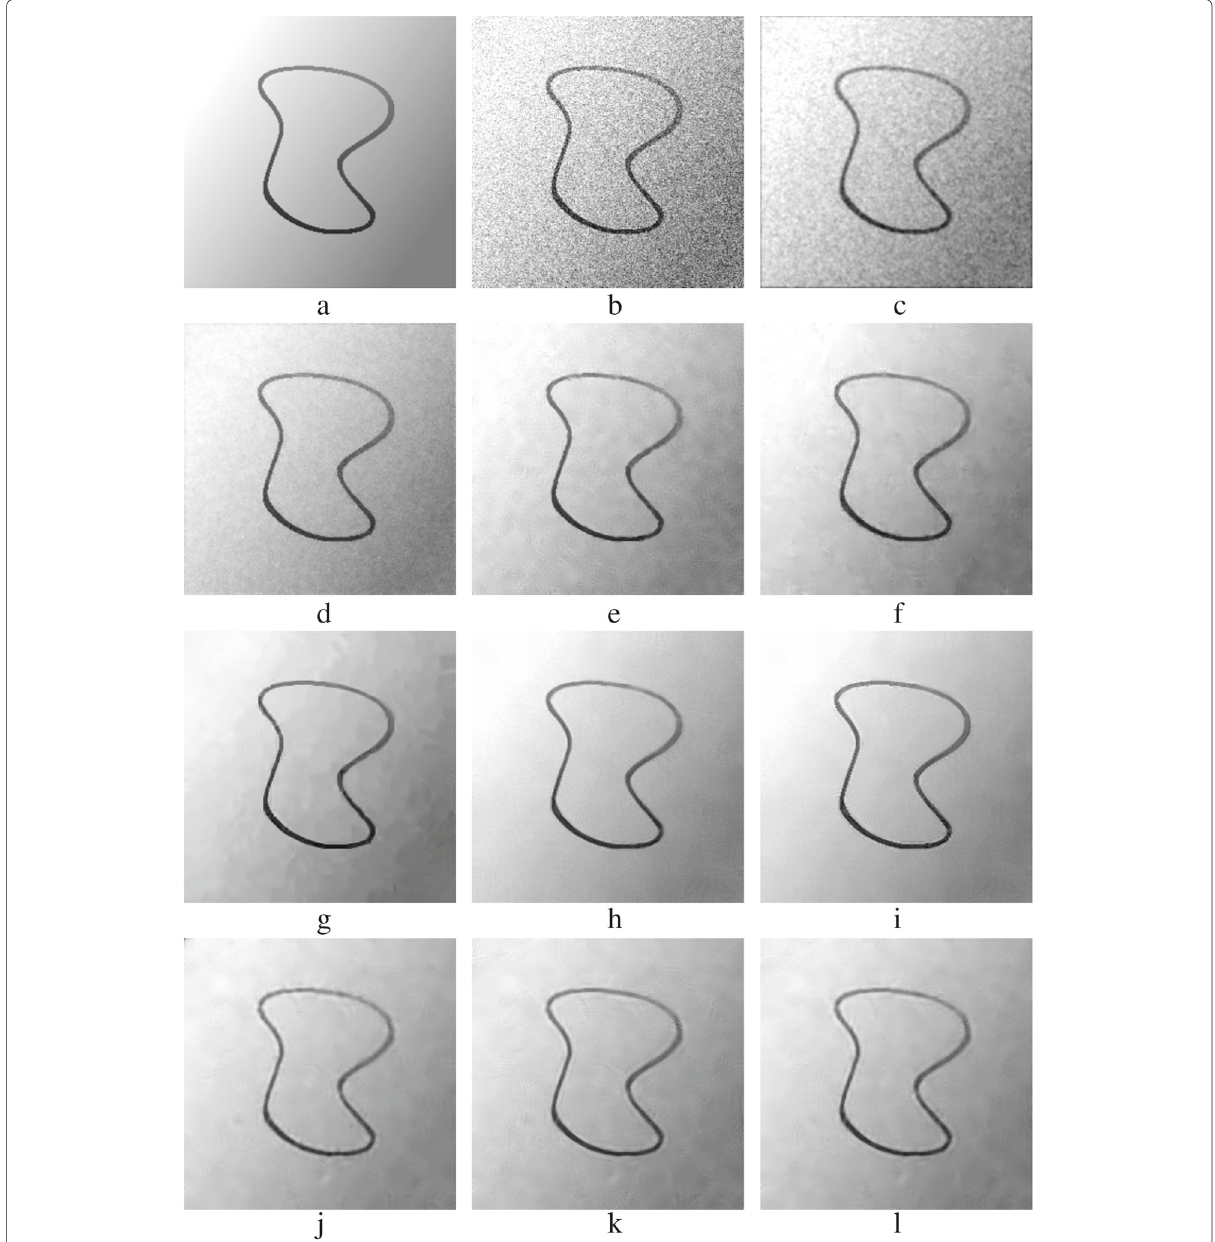
Fig. 19 Denoised CurvedBand images: a original CurvedBand image; b AWG noise, σ = 40; c AD (Perona & Malik); d bilateral filtering; e NL-Means filtering; f K-SVD; g BM3D; h Non-itPPB; i It-PPB; j PGPCA; k PLPCA; and l